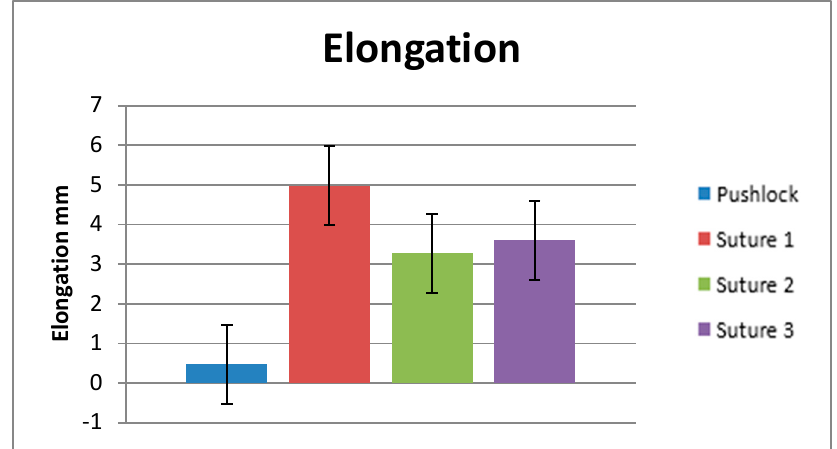
Figure 4. Elongation. Figure 4.